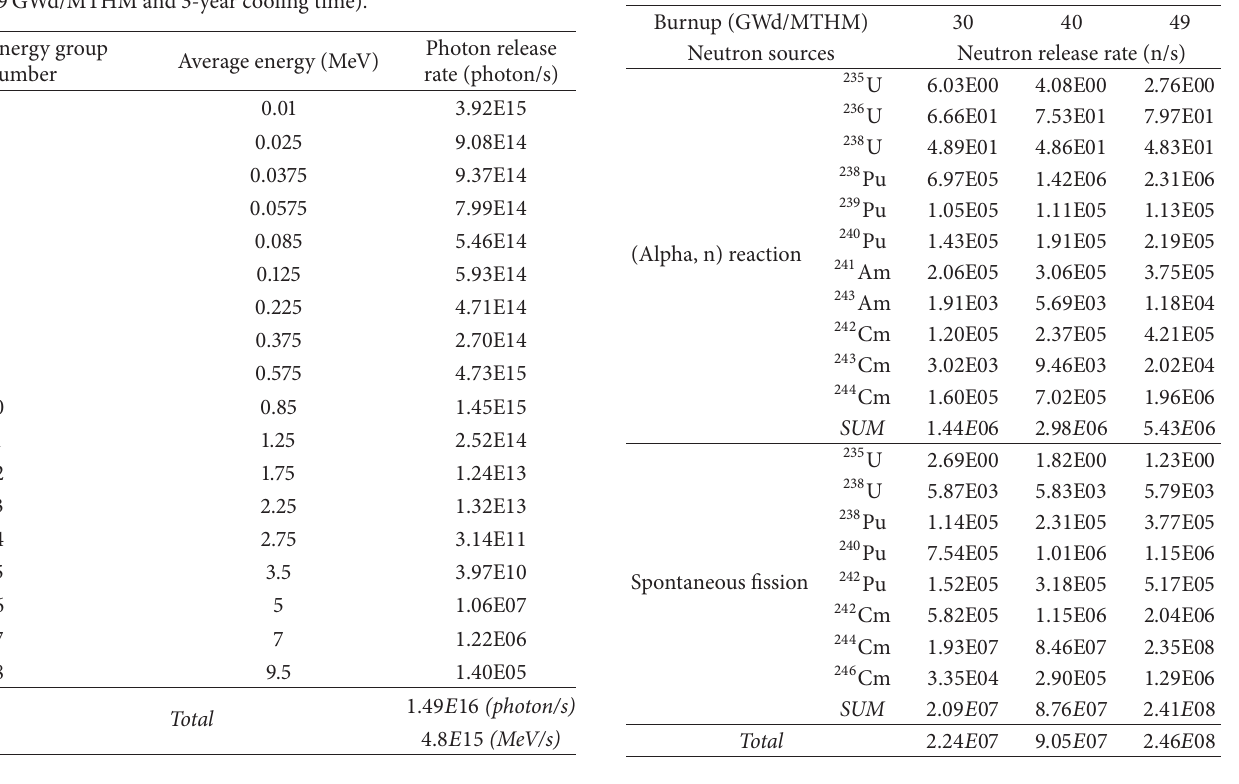
Table 5: Neutron sources of the BNPP SFA (3-year cooling